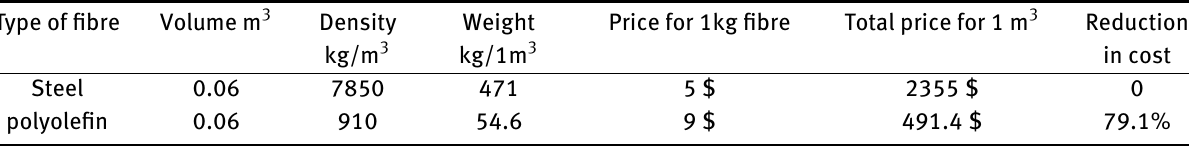
Table 6: Comparison of the cost of